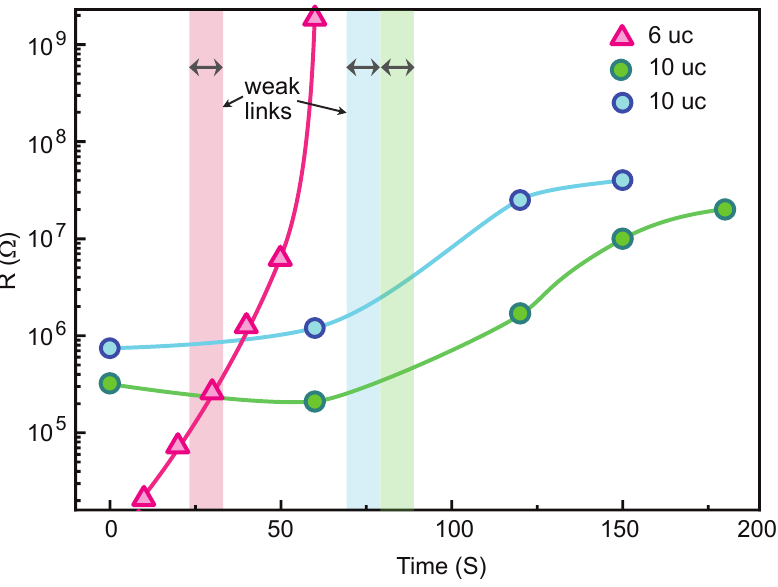
Figure 2. Electrical resistance as a function of Ar + ion beam irradiation time for three different LAO/STO samples (one 6 uc and two 10 uc thick) patterned using electron beam lithography and the negative e-beam resist ma-N2401. All samples were cleaned in RF oxygen plasma for 10 s prior to the irradiation process. Vertical bars indicate the time interval used in the second Ar + ion irradiation of weak links. The electrical resistance was measured in situ during the ion irradiation process in a two-probe configuration. The Ar + ion beam acceleration voltage was 150 V, and the ion current was 30 µ A/cm 2